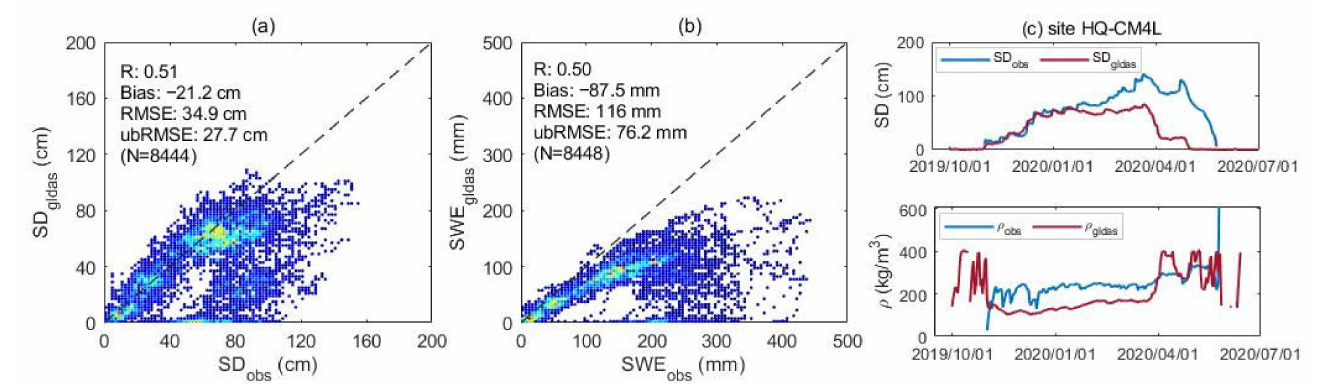
Figure 11. Scatterplots of ( a ) observed SD (snow depth) against reanalysis SD from GLDAS, ( b ) ob- served SWE against reanalysis SWE from GLDAS, and ( c ) time series of observed SD and GLDAS SD at station